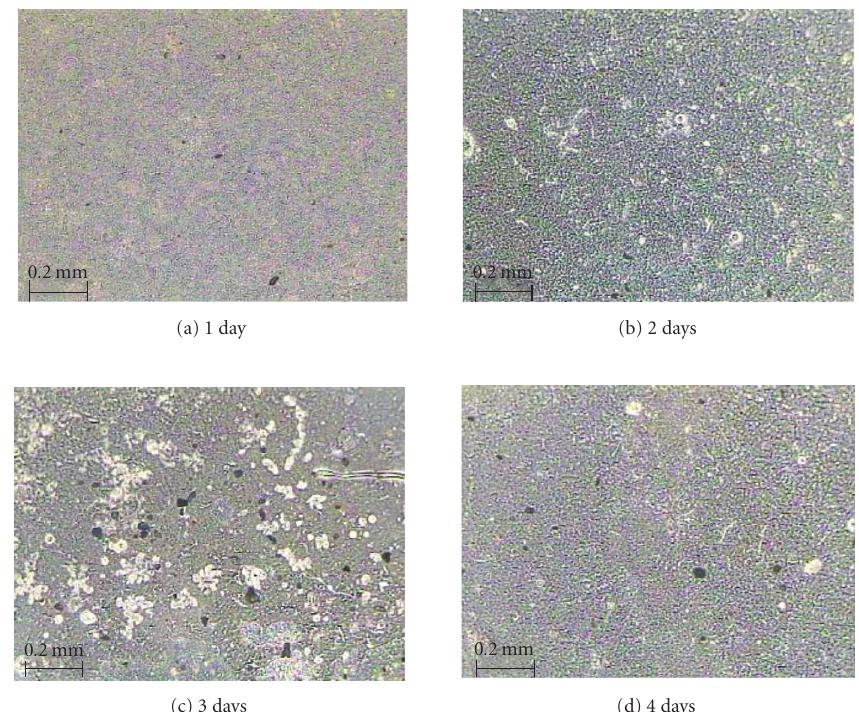
Figure 7: Microphotograph of collagen films before and after di ff erent doses (Table 1) of solar